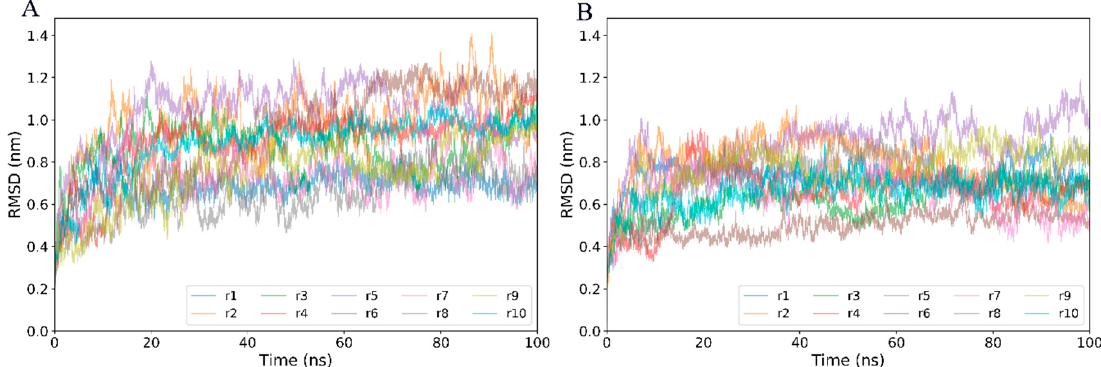
Figure 2. Time evolution of backbone root-mean-square deviation (RMSD) values, with respect to the starting structure calculated from 10 replicas (r1-10). ( A ) CD4-free gp120. ( B ) CD4-complexed gp120.